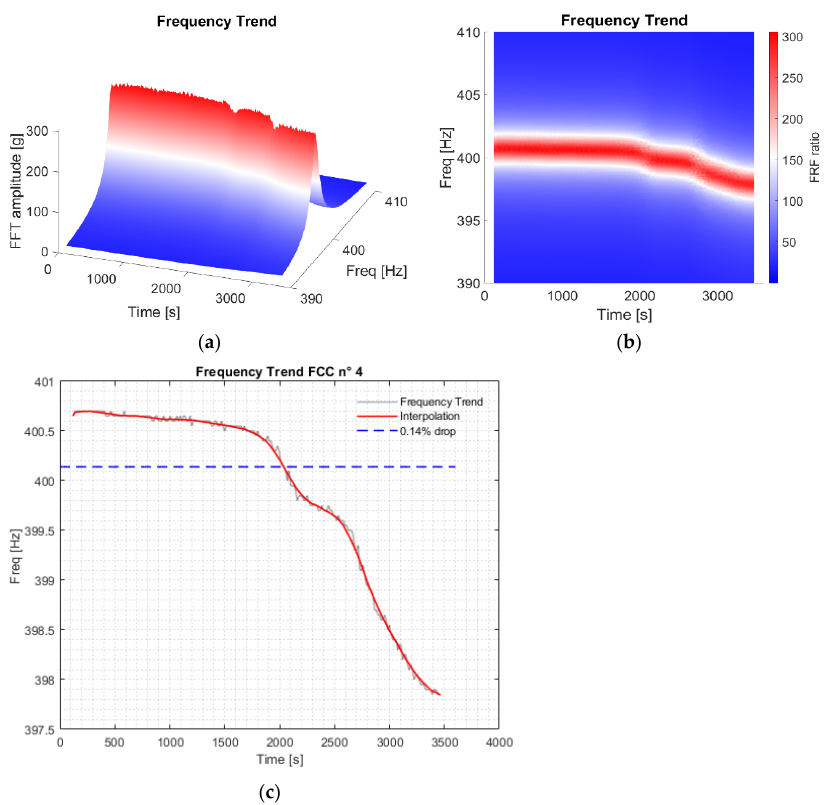
Figure 7. Spectrogram relative to the FCC specimen number 4 tested under random vibration. ( a ) Axonometric and ( b ) top view. The frequency trend is tracked and displayed in ( c ) for a better visualization of the failure time.